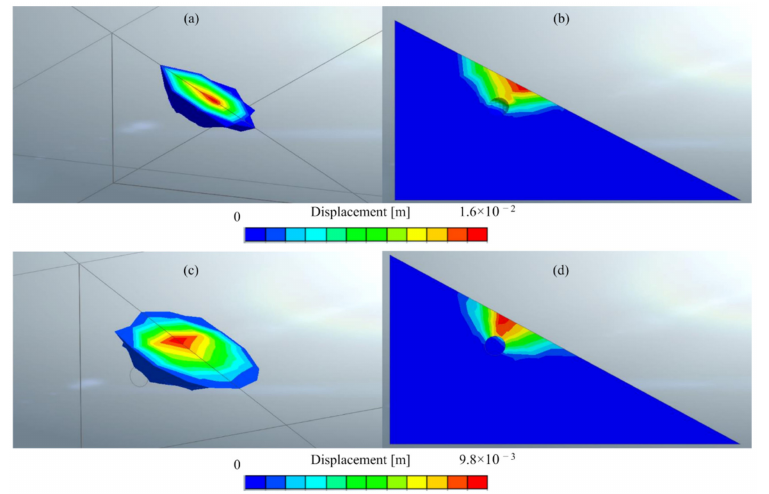
Figure 9. Three-dimensional FEM failure kinematics: ( a ) 3D representation of the soil mass expelled by the static load applied inside the spherical cavity; ( b ) cross section of the failure mechanism associated with the spherical cavity geometry; ( c ) 3D representation of the soil mass expelled by the static load applied inside the cylindrical cavity; ( d ) cross section of the failure mechanism associated with the cylindrical cavity